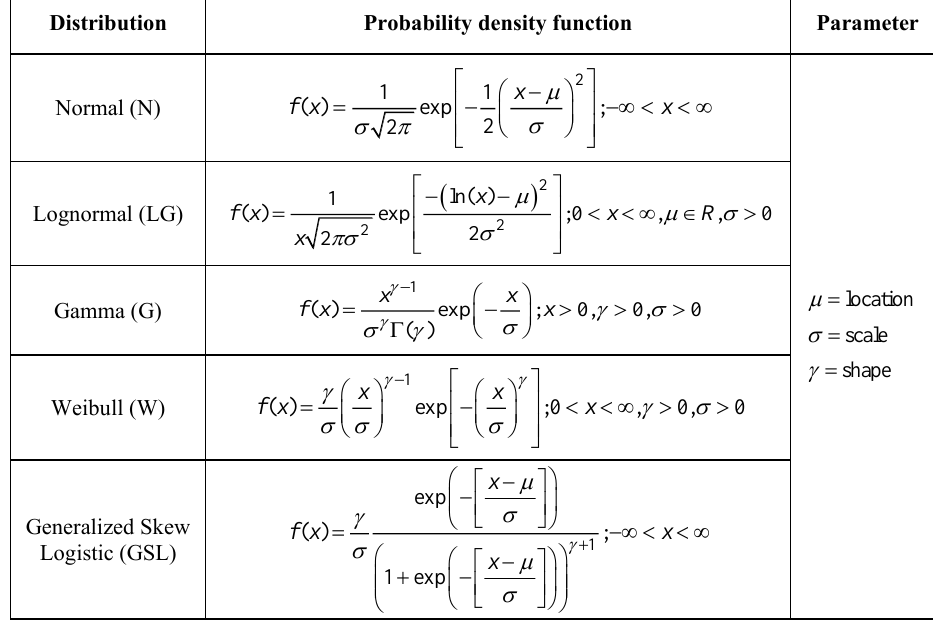
Table 1. The probability density function of five distributions and its parameter. Distribution Probability density function